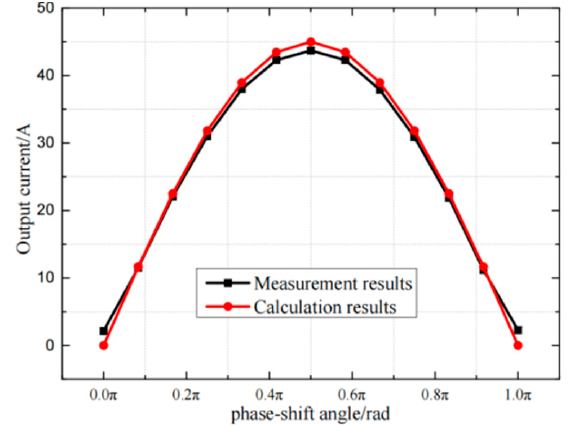
Figure 28. Comparison of output current.